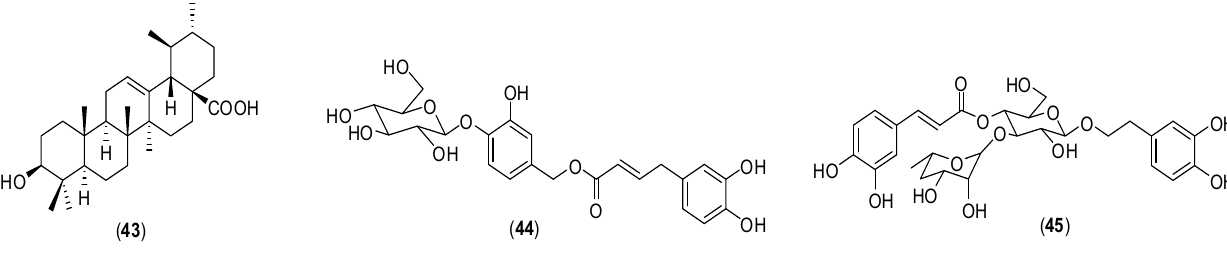
Figure 18. Structure of terpenoid 43 and phenolic compounds 44 and 45